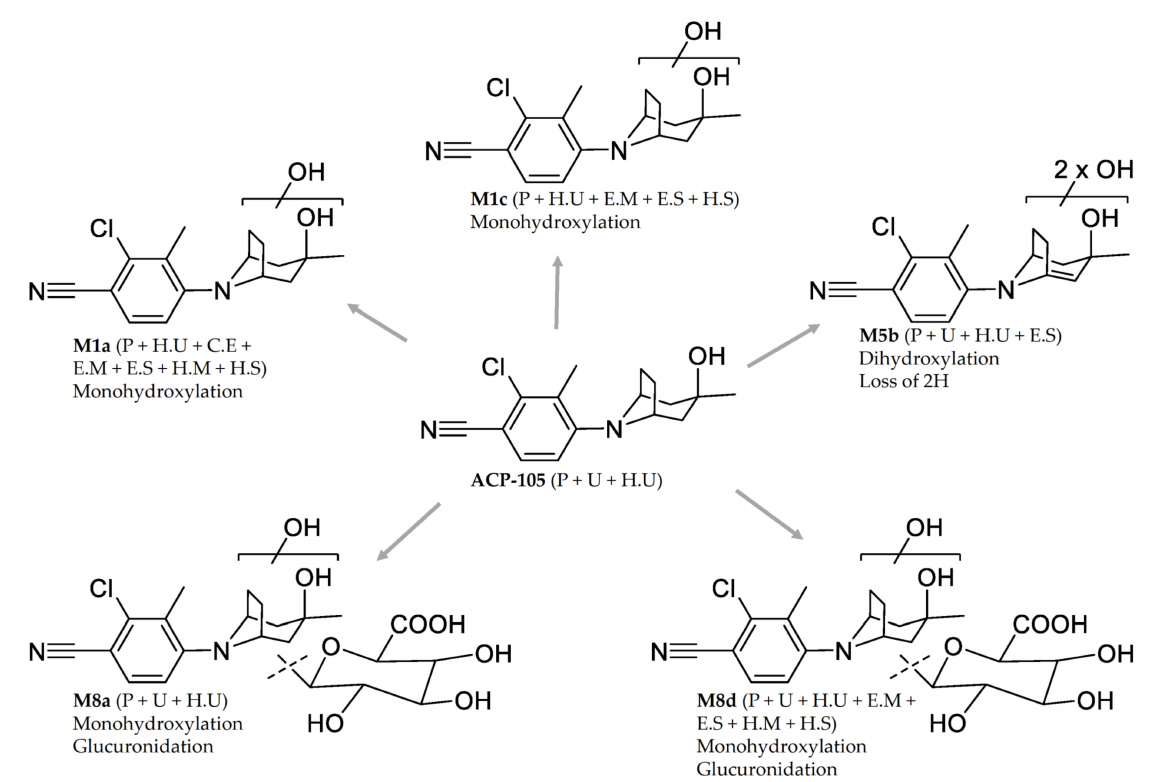
Figure 7. The proposed structures and location of metabolic transformations of the major metabolites from ACP-105. The information within the brackets indicates if they are present in plasma (P) urine (U), hydrolyzed urine (H.U) and incubates with C. elegans (C.E), equine microsomes (E.M), equine S9 fractions (E.S), human microsomes (H.M) and human S9 fractions (H.S). For metabolite M5b, the exact position of the double bond within the aliphatic ring structure is not